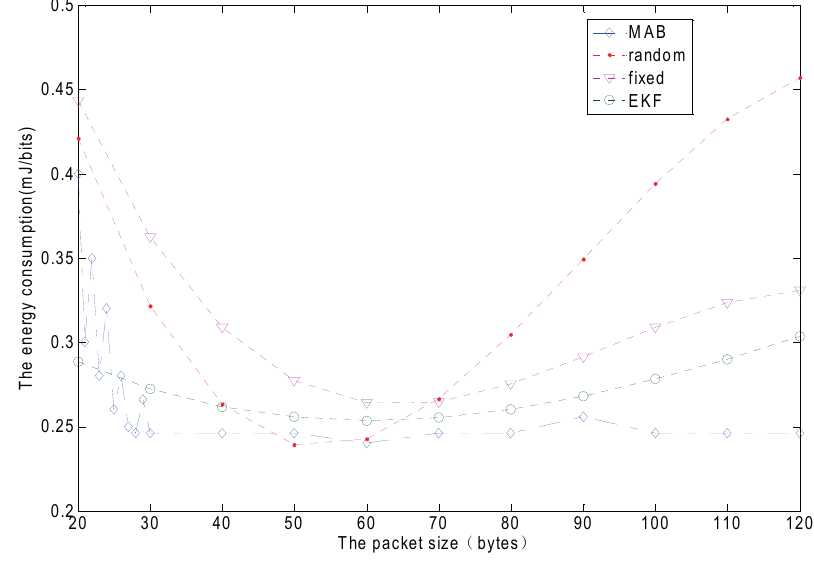
Figure 15. The energy consumption comparison for the different packet size